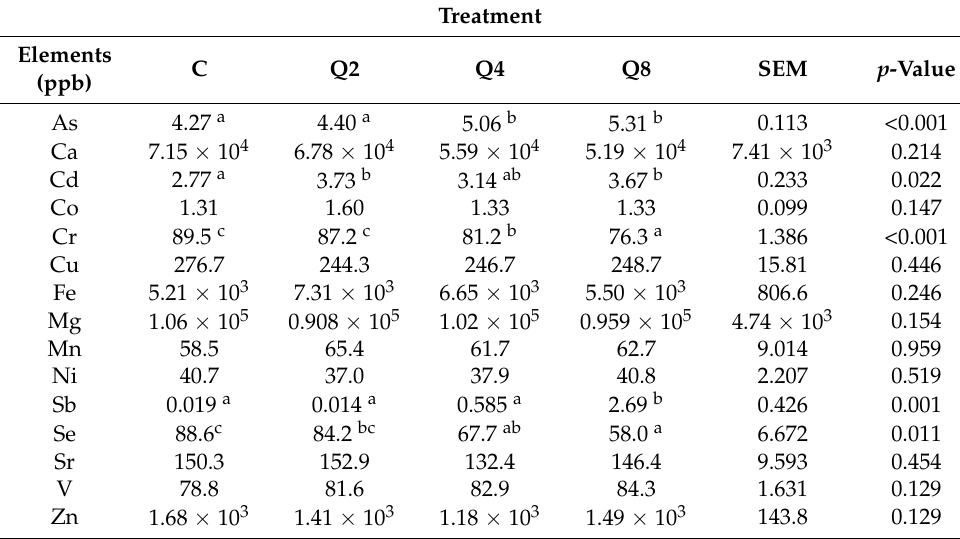
Table 1. The effect of dietary supplementation with quercetin on selected trace- and macro-elements concentrations in laying hens’ egg albumen ( n =